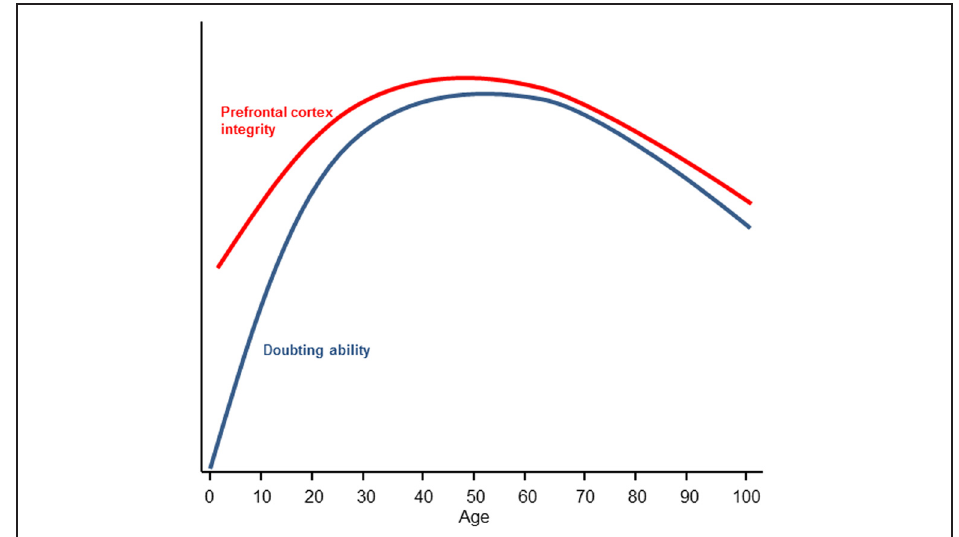
FIGURE 2 | Changes in doubting ability and prefrontal cortex integrity as a function of age. Prefrontal cortex integrity is defined by white matter organization (Klingberg et al., 1999; Pfefferbaum et al., 2005) and is represented by the red inverted U. Doubting ability is represented by the blue inverted U. Early prefrontal integrity development is theorized to track doubting abilities but the initial absence of knowledge representations (which provide discrepant beliefs to form doubt) suggests a steeper ascending curve for doubting ability as knowledge is gained. Late prefrontal integrity development is theorized to be tightly coupled to doubting ability as knowledge is not appreciably diminished in older adults (e.g., Horn and Cattell,